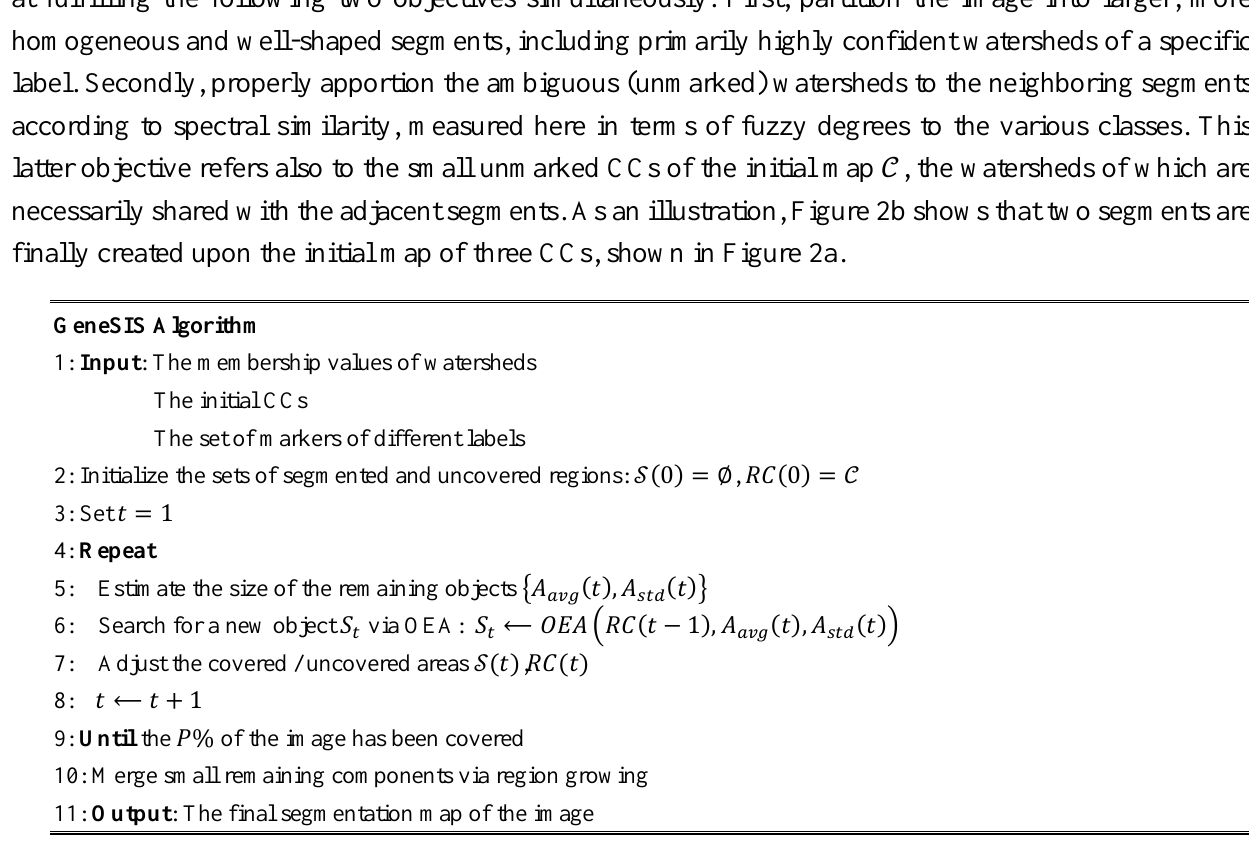
Figure 3. Outline of GeneSIS